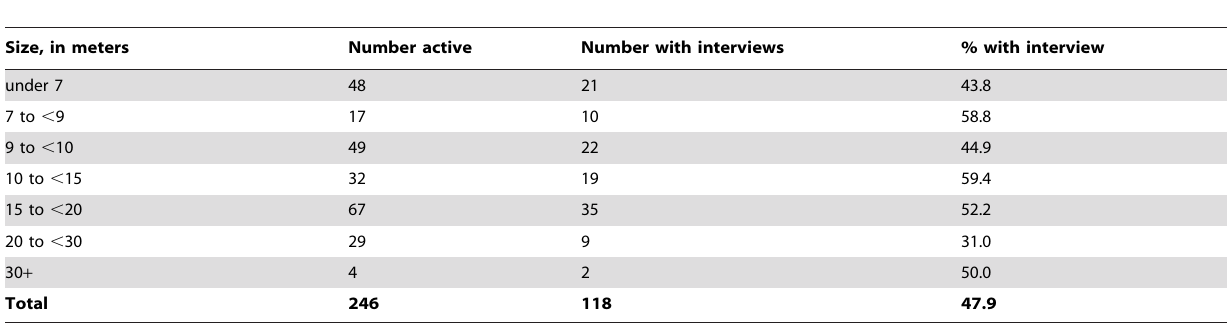
Table 1. Comparision of the number of registered active Northern Ireland fishing vessels and the number with interviews, by size